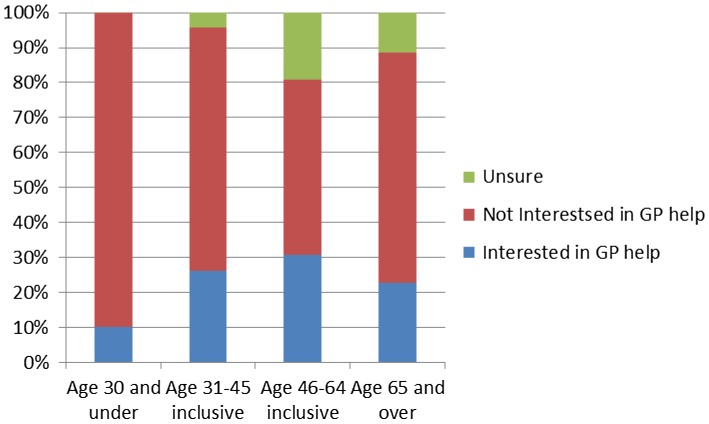
Percentage of patients who were interested in GP help divided into age groups.